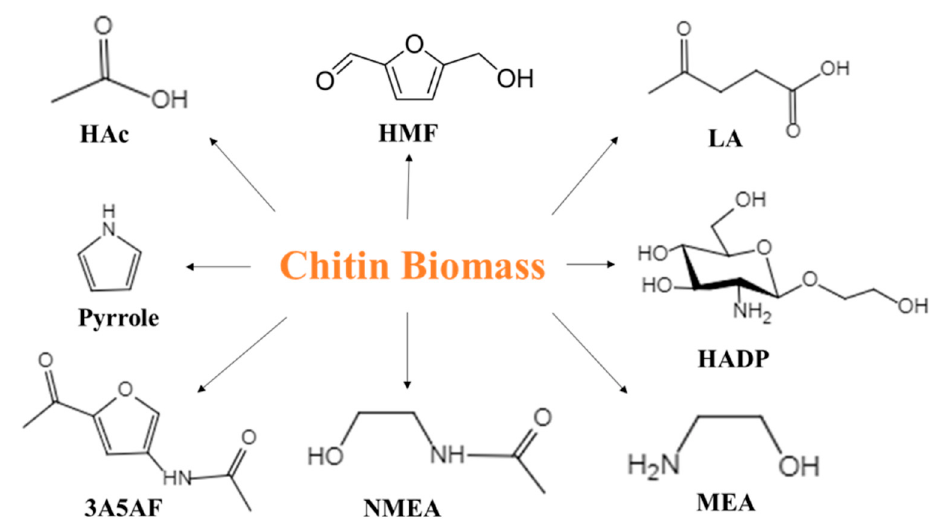
Figure 1. An overview of chitin biomass conversion into various chemicals. HAc, acetic acid; HMF, hydroxymethyl furfural; LA, levulinic acid; HADP, hydroxyethyl-2-amino-2-deoxyhexopyranoside; 3A5AF, 3-acetamido-5-acetylfuran; NMEA, N-acetylmonoethanolamine; MEA, monoethanolamine.